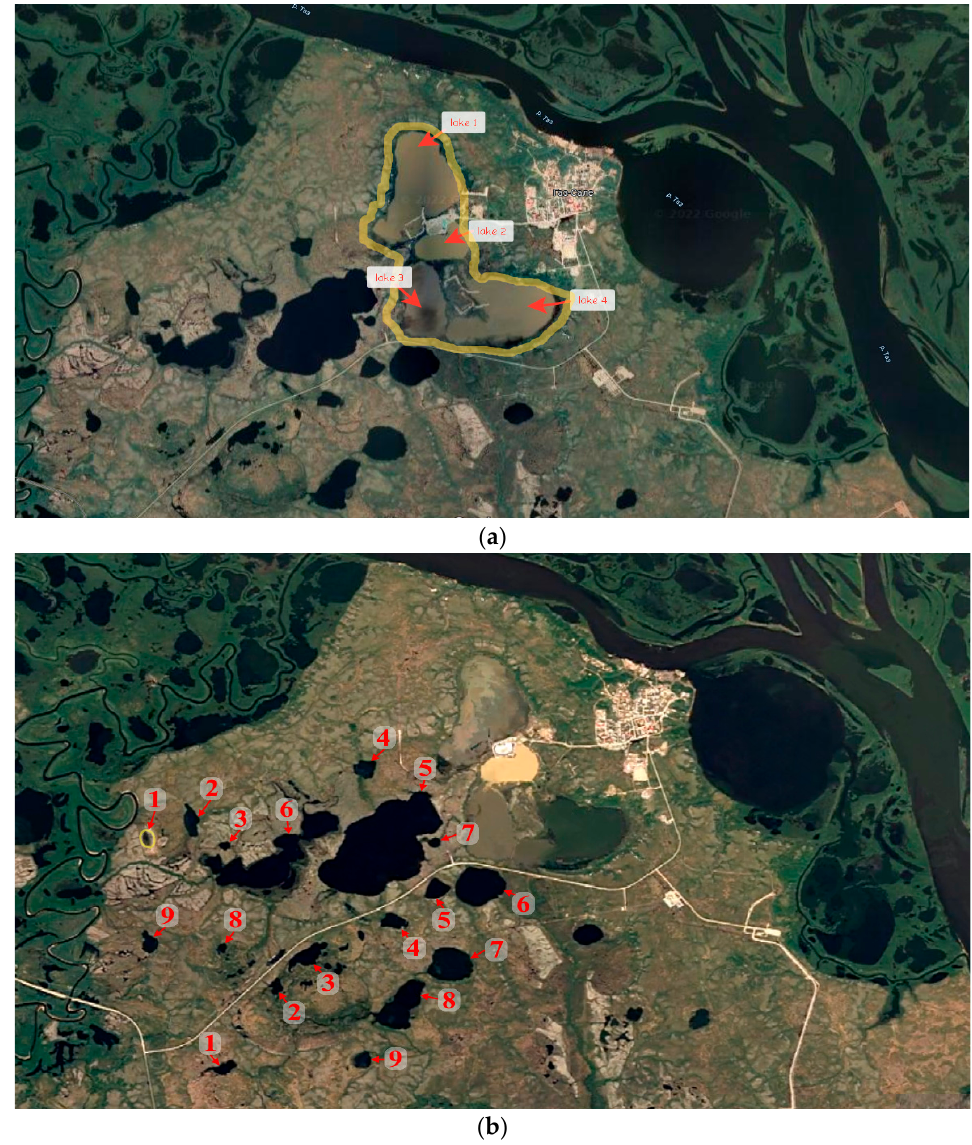
Figure 2. ( a ) The village of Gaz-Sale and the study area showing the four disturbed lakes (D1–D4) in 2014. ( b ) The village of Gaz-Sale and study lakes showing the nine undisturbed lakes above the road (UA1–UA9) and the nine undisturbed lakes below the road (UB1–UB9) in 2014. The yellow outline around lake UA1 denotes the lake which had disappeared by 2019.